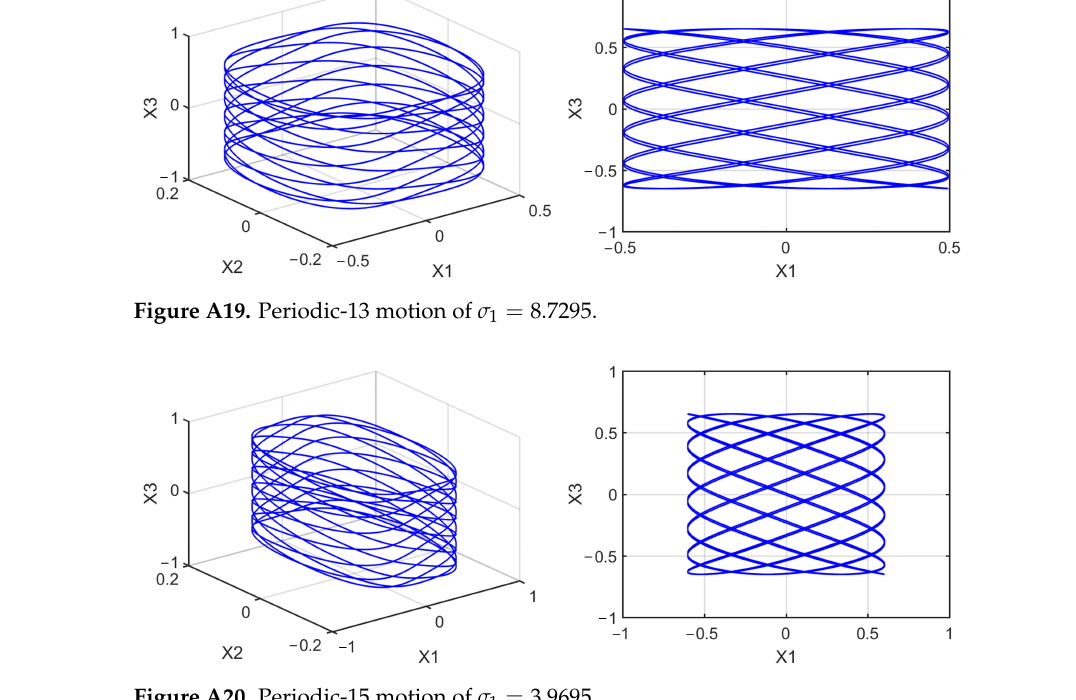
Figure A20. Periodic-15 motion of σ 1 = 3.9695.